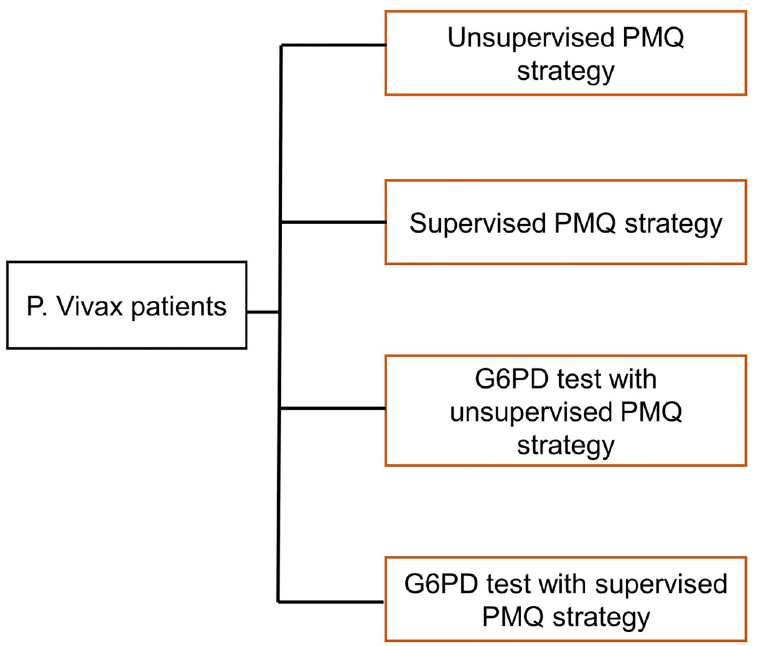
Fig 1. Decision tree model for four P. vivax radical cure